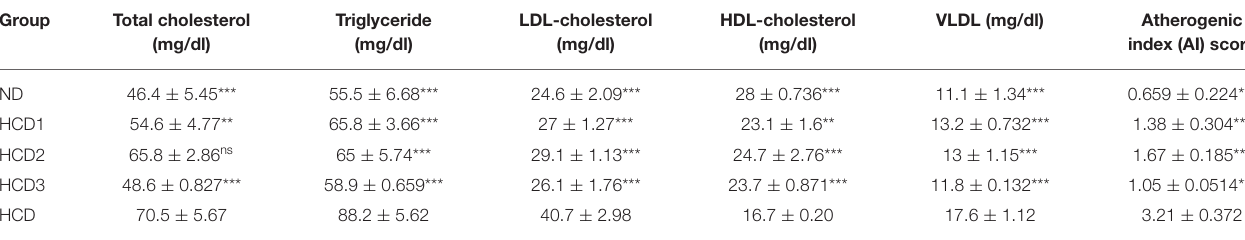
TABLE 7 | Serum total cholesterol, triglyceride, LDL-, HDL-D-cholesterol, VLDL and AI score in experimental rats. Group Total cholesterol Triglyceride LDL-cholesterol HDL-cholesterol VLDL (mg/dl) Atherogenic (mg/dl) (mg/dl) (mg/dl) (mg/dl) index (AI) score ND 55.5 ±